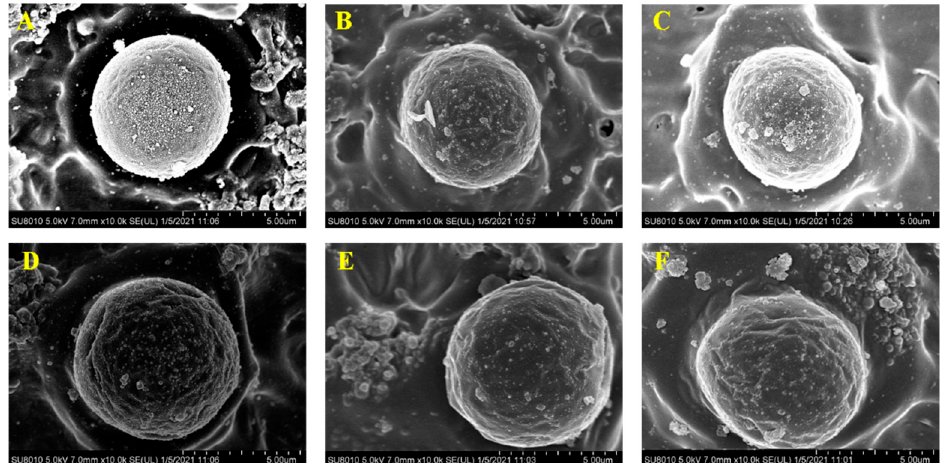
Figure 7. Cryo-SEM images of filled hydrogels treated with different NaCl concentrations. ( A – F ) represented the NaCl concentration of 0, 100, 200, 300, 400, 500 mM.